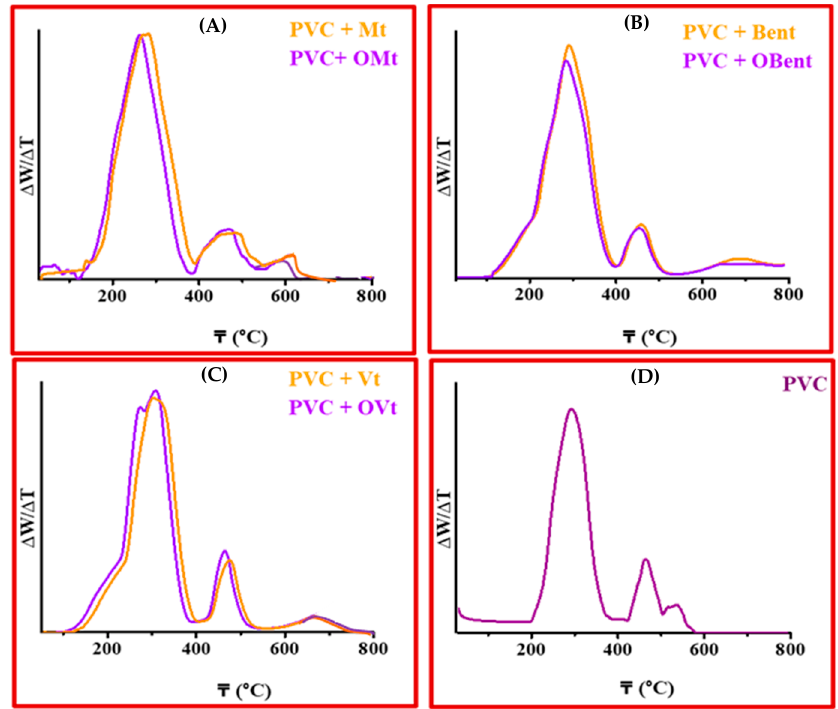
Figure 8. Thermogravimetric analysis (DTG curve) of ( A ) Mt, OMt-based PVC polymer composite, ( B ) Bent, OBent PVC polymer composite film, ( C ) Vt, OVt PVC polymer composite film and ( D ) pure PVC polymer film.